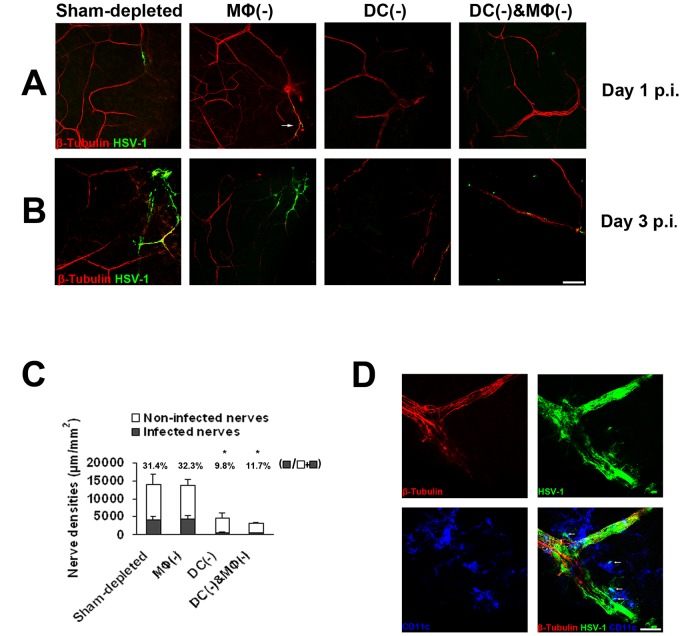
Corneal nerves demonstrate delayed and decreased HSV-1 infection in conventional dendritic cell-depleted corneas.After corneal depletion of cDCs or/and MΦs, or sham depletion, infected corneas (n = 5) were collected for immunohistochemistry studies. A: As early as day as 1 p.i., peripheral corneal nerves co-stained with HSV-1 in sham-depleted or MΦ depleted corneas, while depletion of corneal cDC resulted in no corneal nerve staining with HSV-1. B, C: On day 3 p.i., the percentage of infected nerves was significantly lower with cDC depletion as compared to sham controls and MΦ depleted corneas. D: The representative micrographs show that infected cDCs (arrows) were located adjacently to the infected nerves. Each experiment was replicated three times. *p<0.05 compared with sham-depleted (chi-square test). Data are shown as mean ± SD. Scale bar: 100 μm (A, B); 50μm (D).